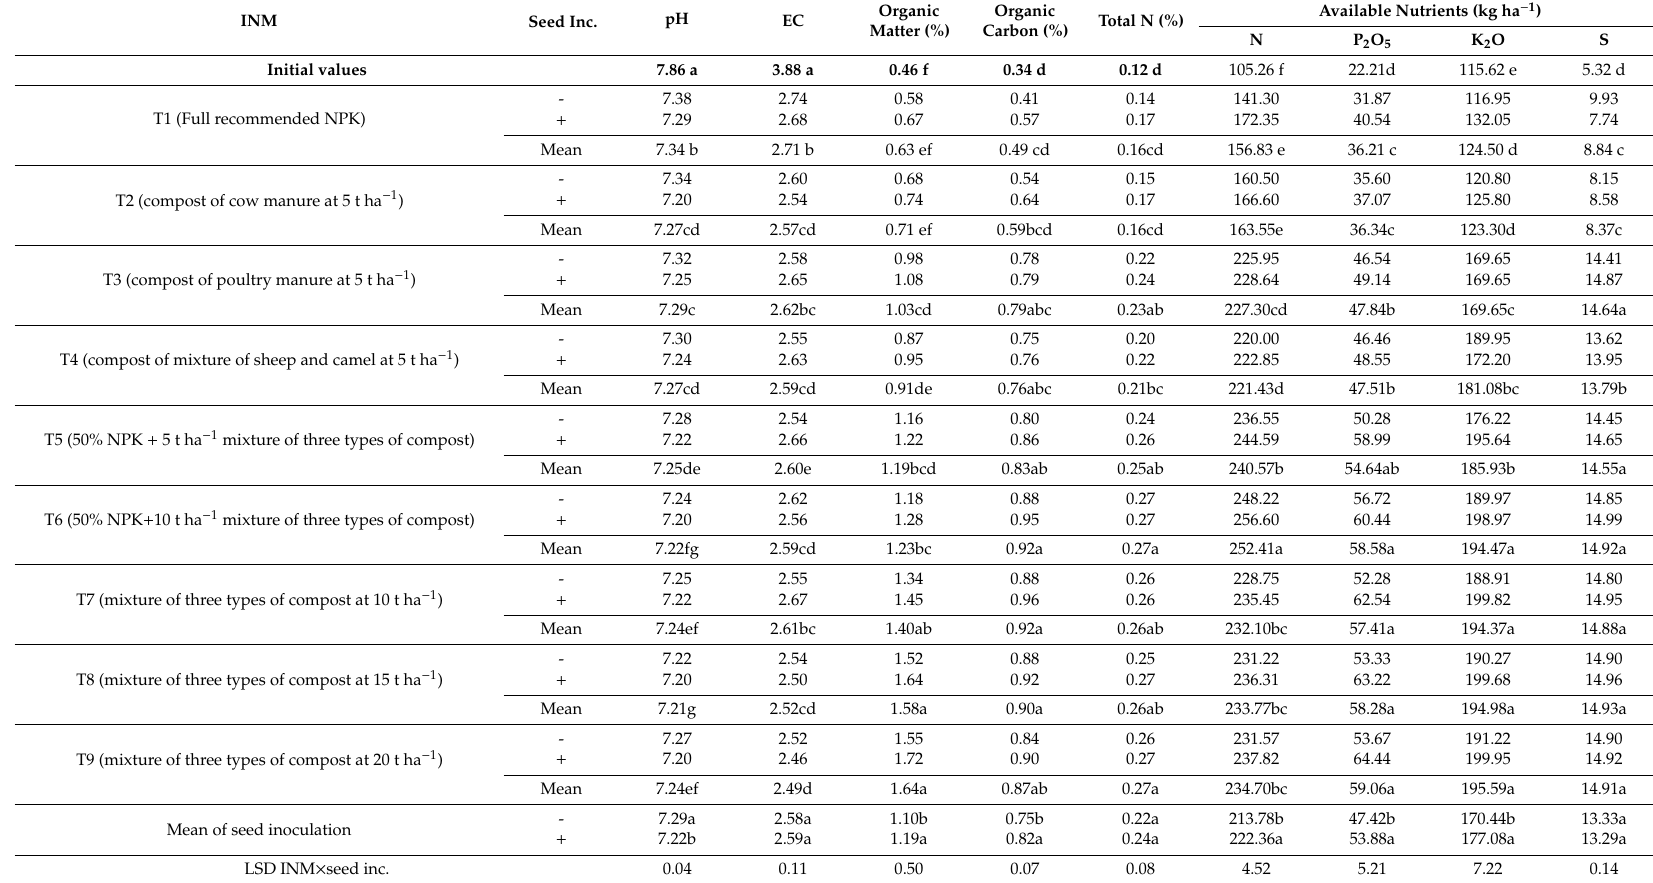
Table 2. E ff ects of di ff erent integrated nutrient management (INM) with ( + ) and without ( − ) seed inoculation (seed Inc.) on soil chemical properties (mean, n = 4) after 2 years of field-scale